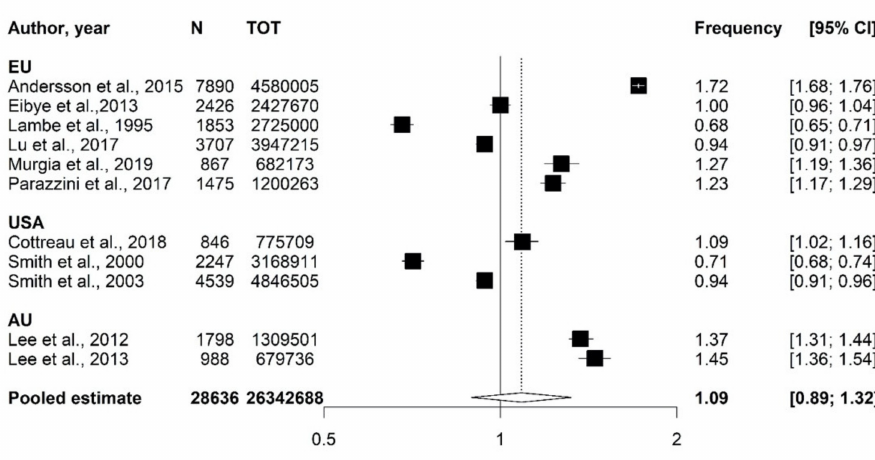
Figure 2. Frequencies of pregnancy-associated cancer (PAC): estimates by study and overall estimate and related 95% confidence